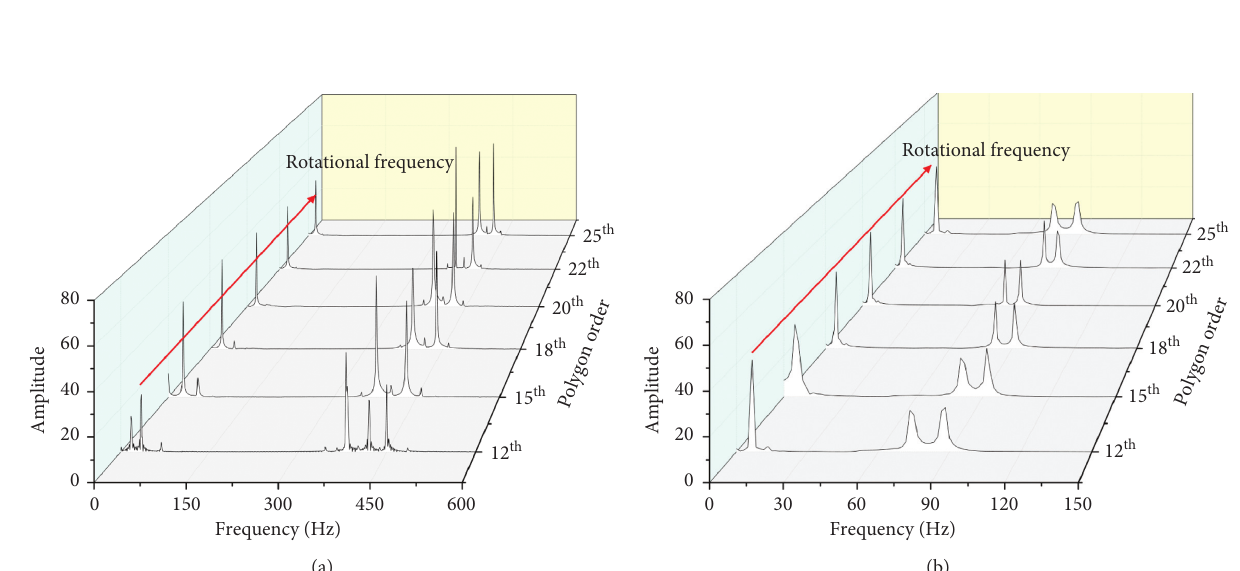
Figure 15: Spectrum analysis results. (a) The stress of the second peak and (b) the stress of the first